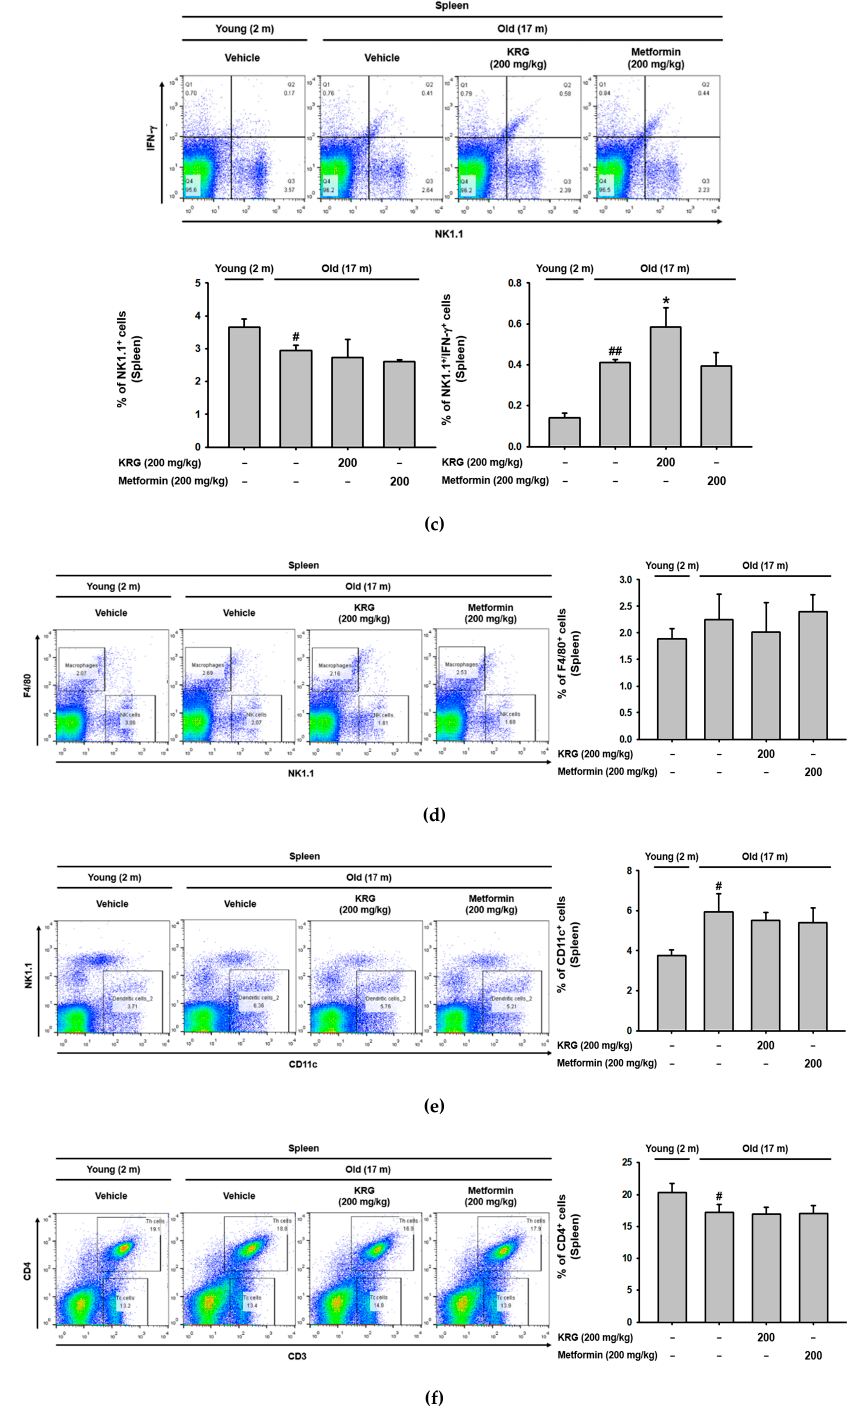
Figure 3. KRG regulated the population of thymic and splenic immune cells in aged mice. ( a ) Total thymic cells were stained for CD25 and Foxp3, and CD25 + / Foxp3 + cells were analyzed using flow cytometry and plotted. ( b ) Total splenic cells were stained for CD25 and Foxp3, and CD25 + / Foxp3 + cells were analyzed using flow cytometry and plotted. ( c ) Total splenic cells were stained for NK1.1 and IFN- γ , and NK1.1 + / IFN- γ + cells were analyzed using flow cytometry and plotted. ( d ) Total splenic cells were stained for F4 / 80 and NK1.1, and F4 / 80 + cells were analyzed using flow cytometry and plotted. ( e ) Total splenic cells were stained for CD11c and NK1 / 1, and CD11c + cells were analyzed using flow cytometry and plotted. ( f ) Total splenic cells were stained for CD4 and CD3, and CD4 + cells were analyzed using flow cytometry and plotted. # p < 0.05, ## p < 0.01 compared to vehicle-administered control young mice, and * p < 0.05 compared to vehicle-administered control old